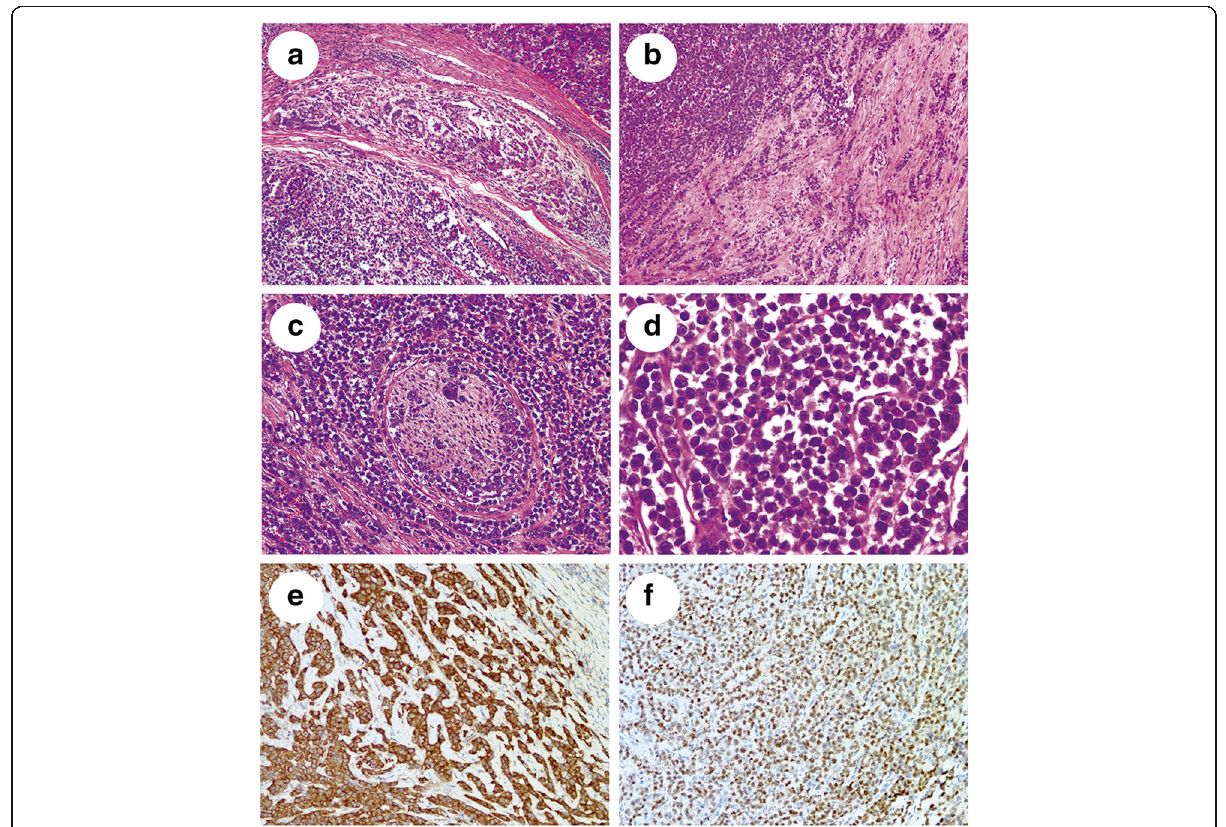
Fig. 2 Photomicrograph of the lesion in pancreas. a : The malignant cells infiltrating the lobules of pancreas (H&E, ×100). b : The tumor cells arranging in the form of solid sheets and single files (H&E, ×100). c : The tumor cells demonstrating a targetoid growth pattern and nerve invasion (H&E, ×200). d : High magnification showing the polygonal cell contours, abundant eosinophilic cytoplasm, high nuclear to cytoplasmic ratio and loss of cohesion (H&E, ×400). e : Diffuse strong cytoplasmic staining for p120 (Envision, ×200). f : Diffuse strong nuclear staining for GATA3 (Envision,